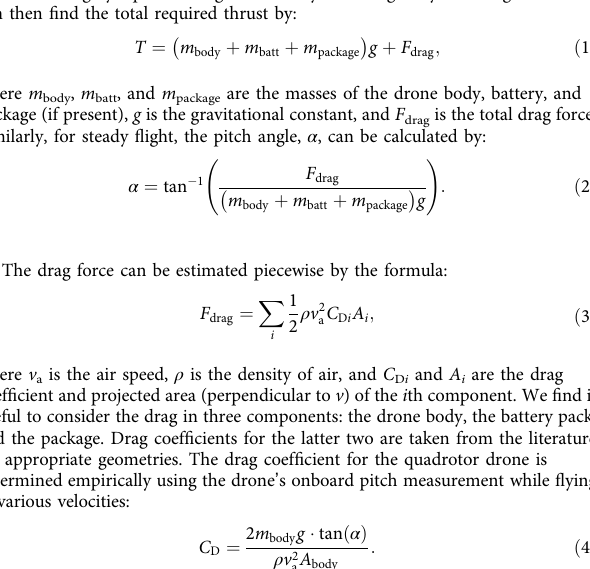
Fig. 5 Comparison of life-cycle greenhouse gas emissions per package delivered for drone and ground vehicle pathways under base case assumptions. The analysis focuses on the fi nal delivery of the package, after the package is delivered to the regional warehouse. Emissions from battery and fuels production, as well as fuels combustion and electricity production required for transportation and warehousing, are included. The range of regional greenhouse gas (GHG) intensities of electricity in the U.S. is represented by comparing results from low-carbon California to relatively high-carbon Missouri. Additional warehousing requirements for drone and van pathways are included. The results show that small quadcopter drones across all U.S. regions have lower